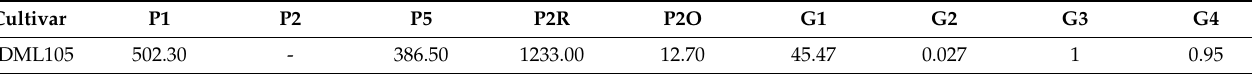
Table 2. Genotype coefficient of Khao Dawk Mali 105